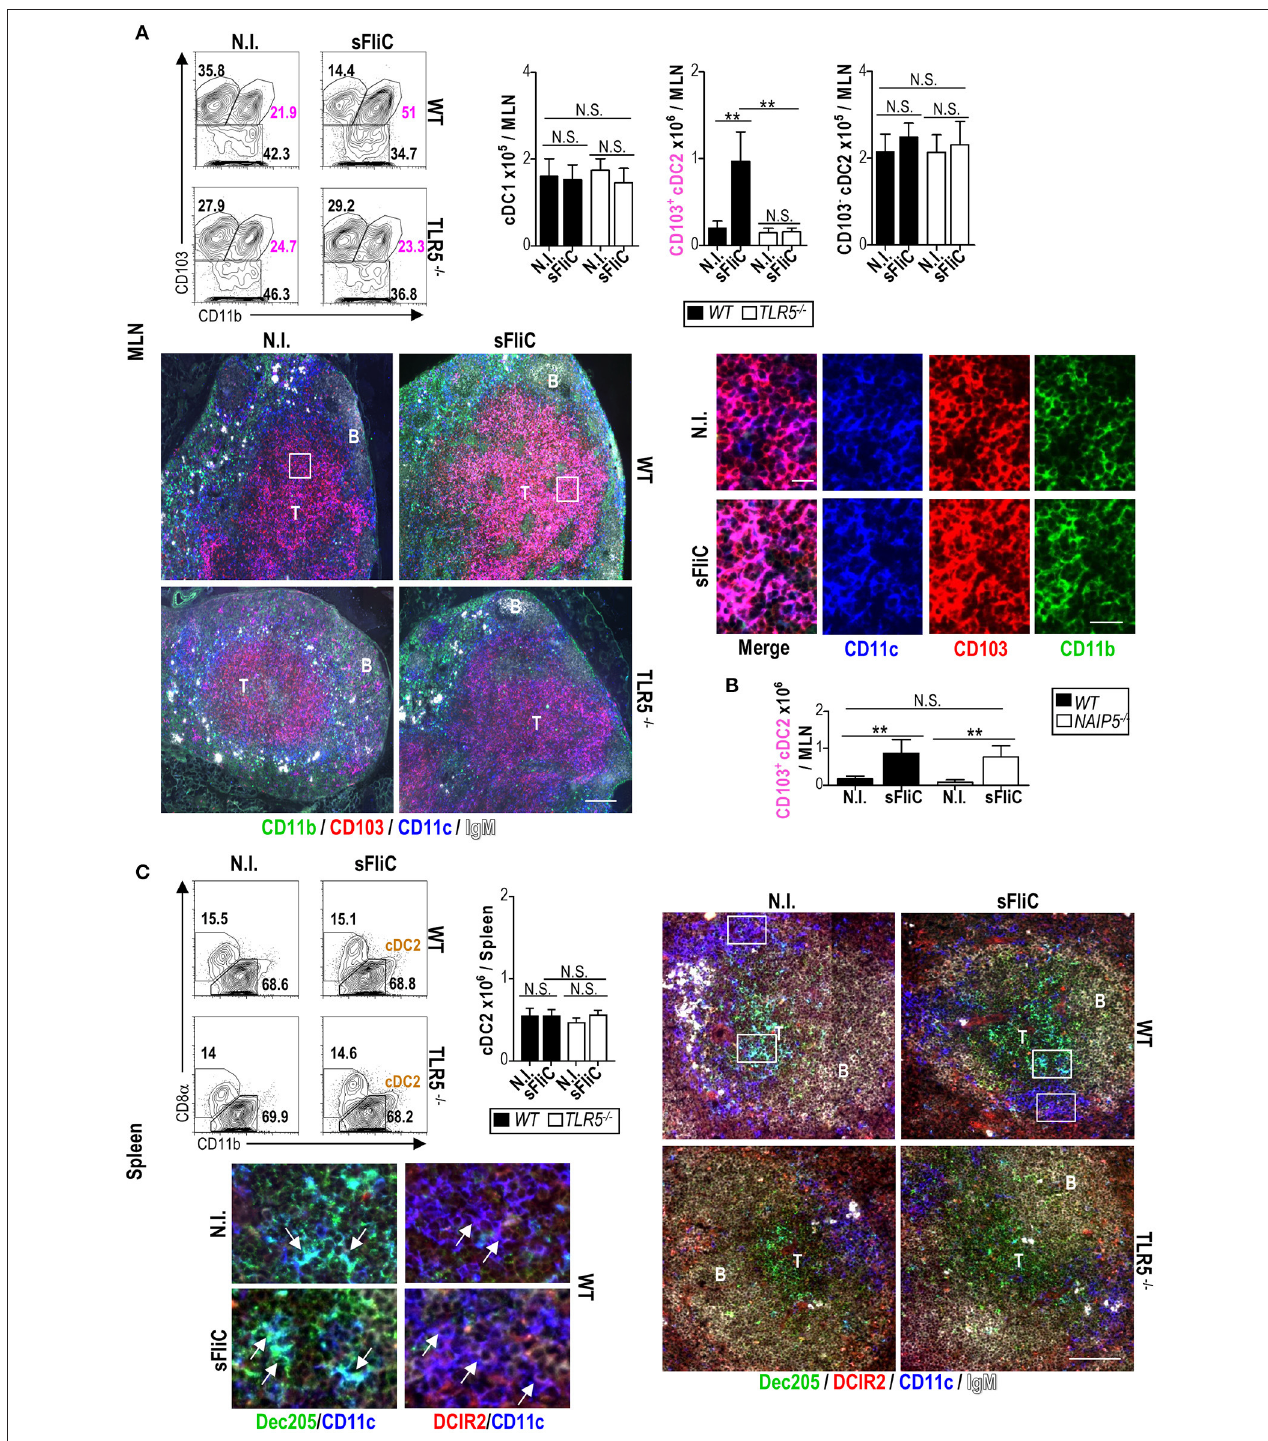
FIGURE 1 | Mucosal CD103 + cDC2 respond to sFliC immunization in a TLR5-dependent manner. Wild-type (WT) or TLR5 − / − mice were immunized i.p. with sFliC and cDCs (Lin − MHC-II hi CD11c hi ) were evaluated 24h later, alongside non-immunized (N.I.) mice. (A) MLN representative flow cytometry plots (including percentages) of cDC1 (Lin − MHC-II hi CD11c hi CD11b − CD103 + ), CD103 + cDC2s (Lin − MHC-II hi CD11c hi CD11b + CD103 + ) and CD103 − cDC2 (Lin − MHC-II hi CD11c hi CD103 − ) are shown with adjacent graphs of absolute numbers. Representative photomicrographs of MLN sections stained for CD11c; blue, CD103; red, CD11b; green, and IgM; white (scale bar = 200 µ m) are shown (top right). Zoom-in insets (white boxes) show single staining and a merge of CD11c, CD103, and CD11b (scale bar = 20 µ m).